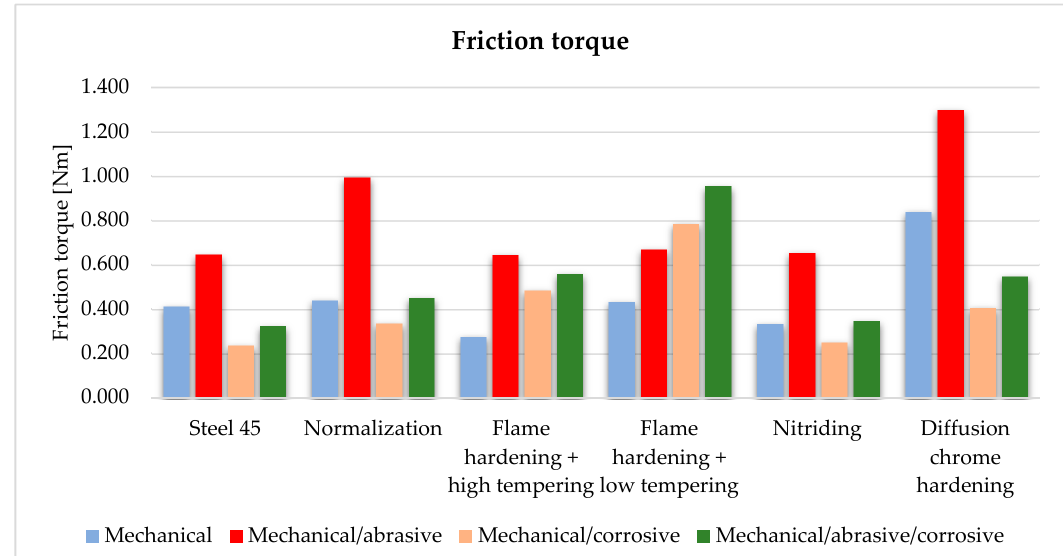
Figure 12. Friction torque for all the samples.